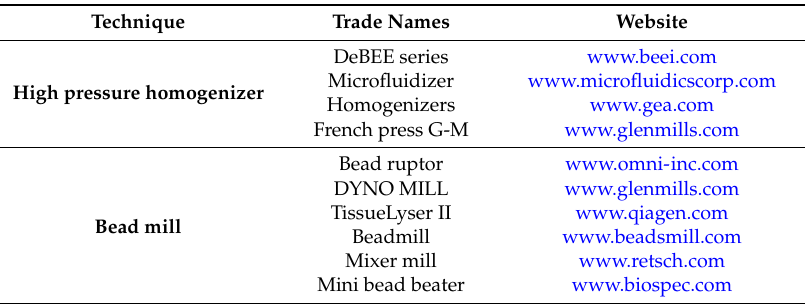
Table 1. List of commercially available mechanical cell lysis